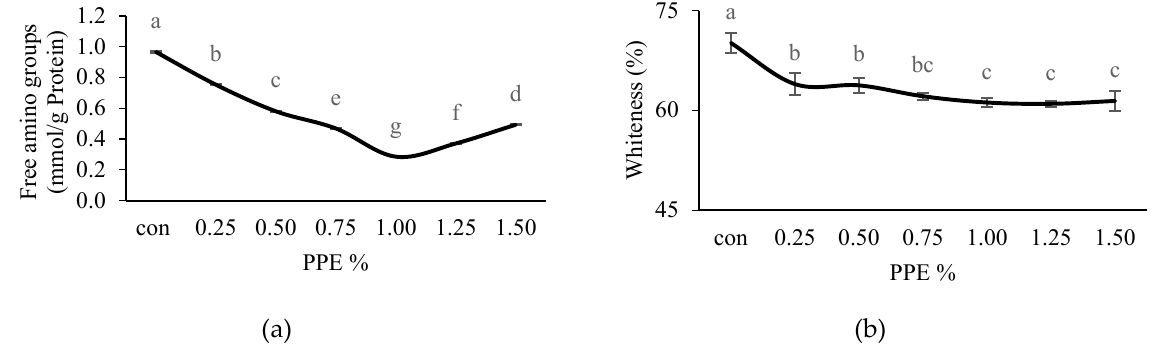
Figure 5. Effects of PPE powder at different concentration (0-1.5%, w / w ) on the silver carp surimi gels free amino groups ( a ) and whiteness ( b ); con: control-without PPE. Different letters (a, b, c, etc.) on the bars indicate significant differences ( p < 0.05).